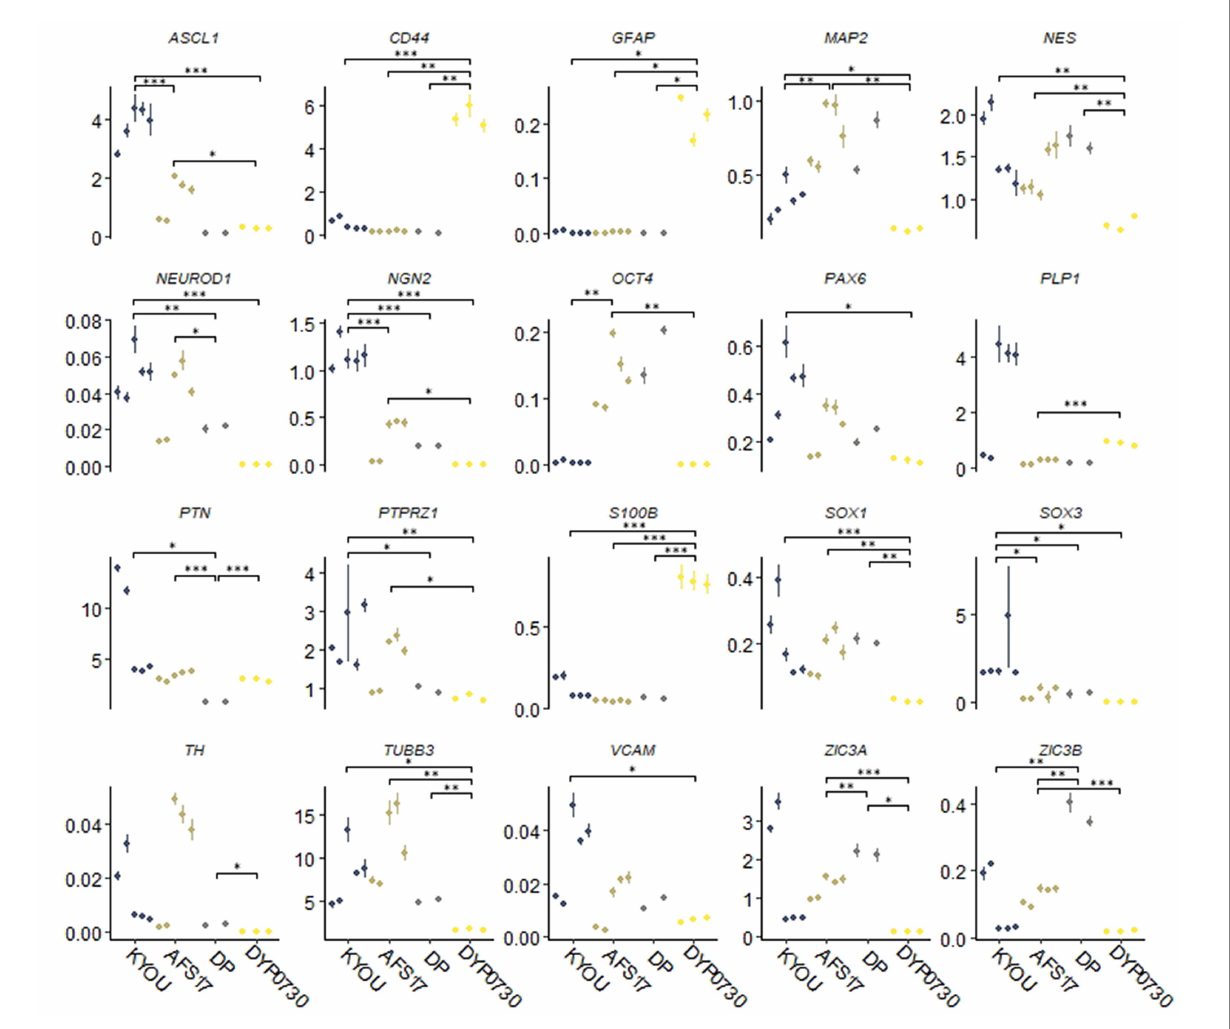
FIGURE 2 Results of quantitative RT-PCR analysis of marker gene expression levels in different neural cultures (N-KYOU, N-AFS17, N-DP, N-DYP0730) obtained from the corresponding NSCs at passage 5. On the ordinate axis is the expression level calculated by the −ΔΔС t method, normalized to the expression of housekeeping genes. Each dot represents a biological replicate collected separately at a different time point (N-KYOU–5 replicates, N-AFS17–5 replicates, N-DP–2 replicates, N-DYP0730–3 replicates). The error bars indicate the standard deviation of the technical replicates, as determined by RT-qPCR. Asterisks indicate the statistical significance of the differences between the specified sample groups, calculated by the Welch test (*value of p <0.05, ** value of p <0.01, *** value of p <0.001), full statistics are available in Supplementary Table